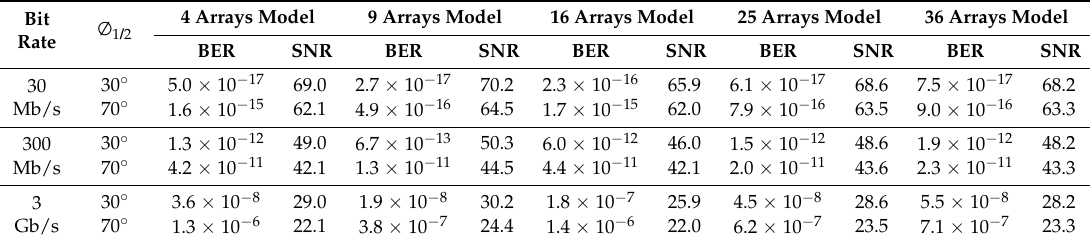
Table 9. Minimum bit error rate (BER) and its corresponding signal to noise ratio (SNR) for the five configurations.